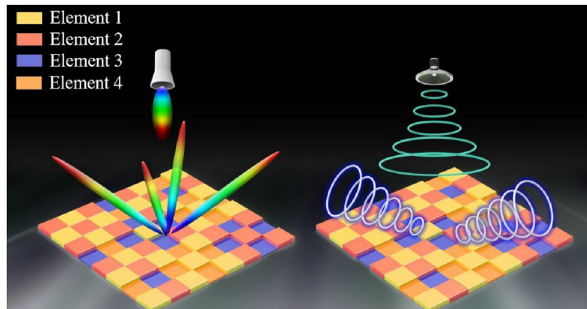
Figure 17: Schematic of the patterned MM and the corresponding EM scattering patterns at 6.0 GHz and acoustic ones at 6860 Hz under normal incidence [105]. Reprinted from [105], with the permission of American Chemical Society Publishing. © 2019, American Chemical Society.